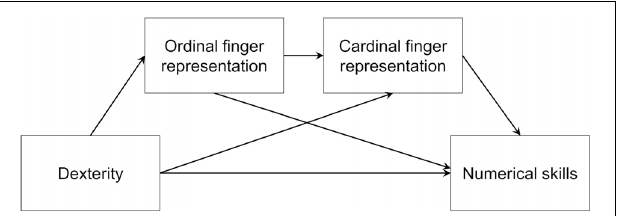
FIGURE 1 | Hypothetical mediation between dexterity and numerical skills via finger-based number